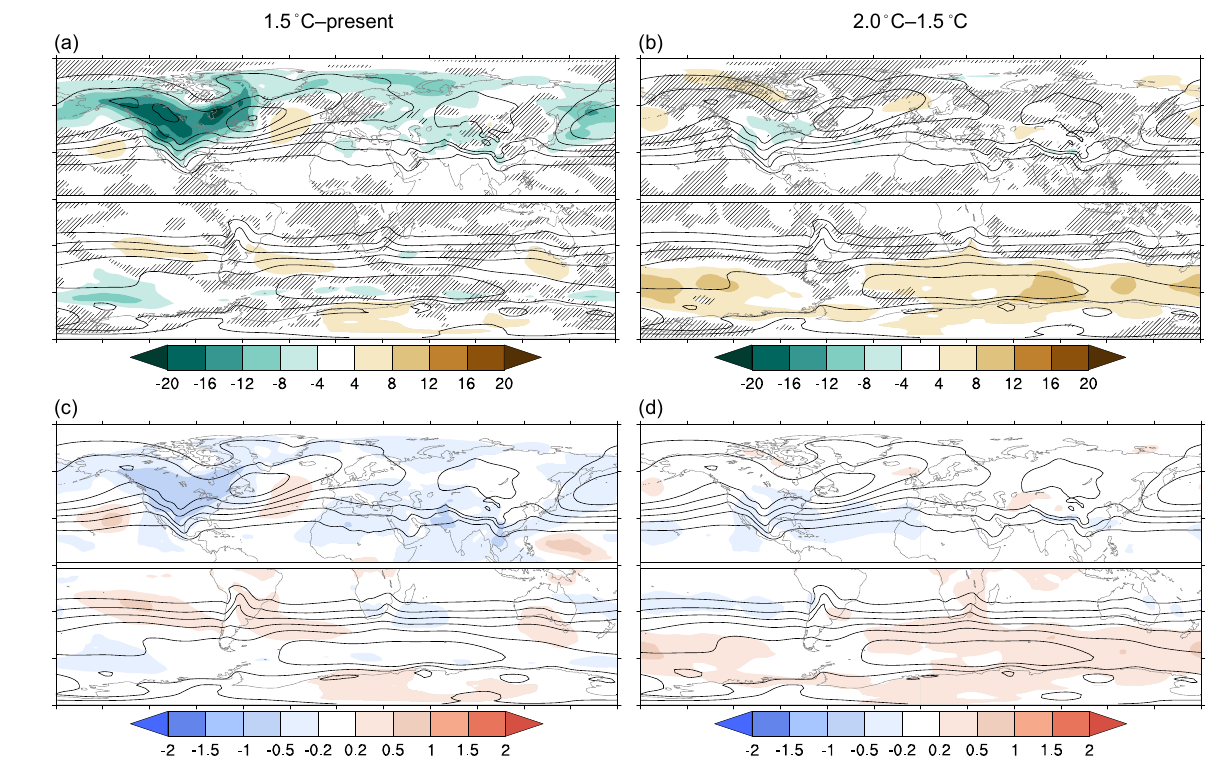
Figure 8. Multi-model mean response of winter (Northern Hemisphere DJF, Southern Hemisphere JJA) low-level MSLP (cid:48) storm tracks for 1.5 ◦ C–PD (a, c) and 2.0–1.5 ◦ C (b, d) . Panels (a) and (b) show responses (shading; unitshPa) along with the climatology (contour interval 100hPa) for the (a) PD and (b) 1.5 ◦ C experiments. Panels (c) and (d) show signal-to-noise ratio β/σ , where the sign corresponds to the sign of the response, along with the climatology (contour interval 100hPa) for the (c) 1.5 ◦ C and (d) 2.0 ◦ C experiments. In (a) and (b) , hatching masks out regions where there is no model consensus (fewer than four out of five models agree) on the sign of the response. In (c) and (d) , black dots mask out regions where the models do not agree on the magnitude of the response ( f 2 > 1). The storm tracks are defined as the standard deviation of bandpass filtered daily